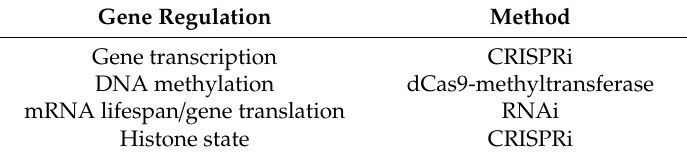
Table 1. Molecular methods used to target di ff erent gene regulation systems in